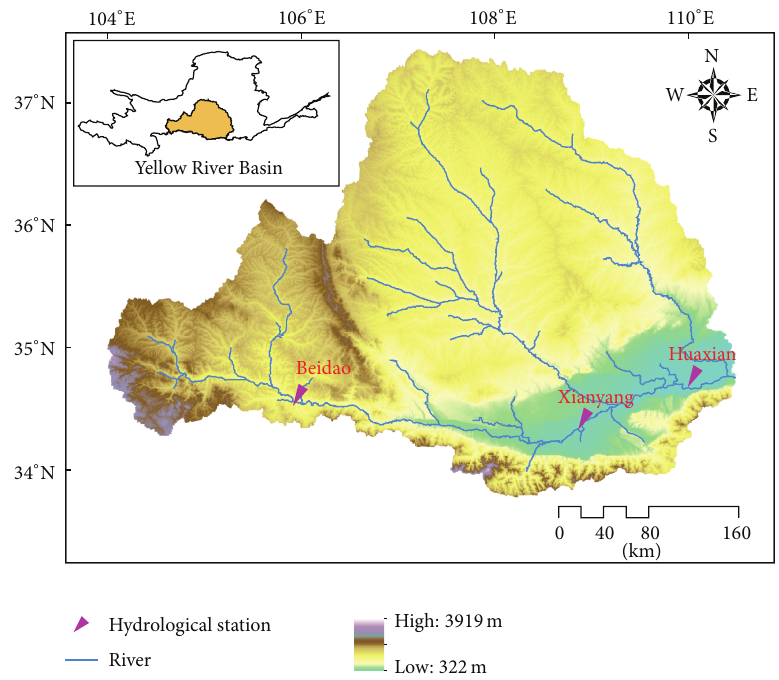
Figure 1: Location of Wei River and hydrological station in Yellow River